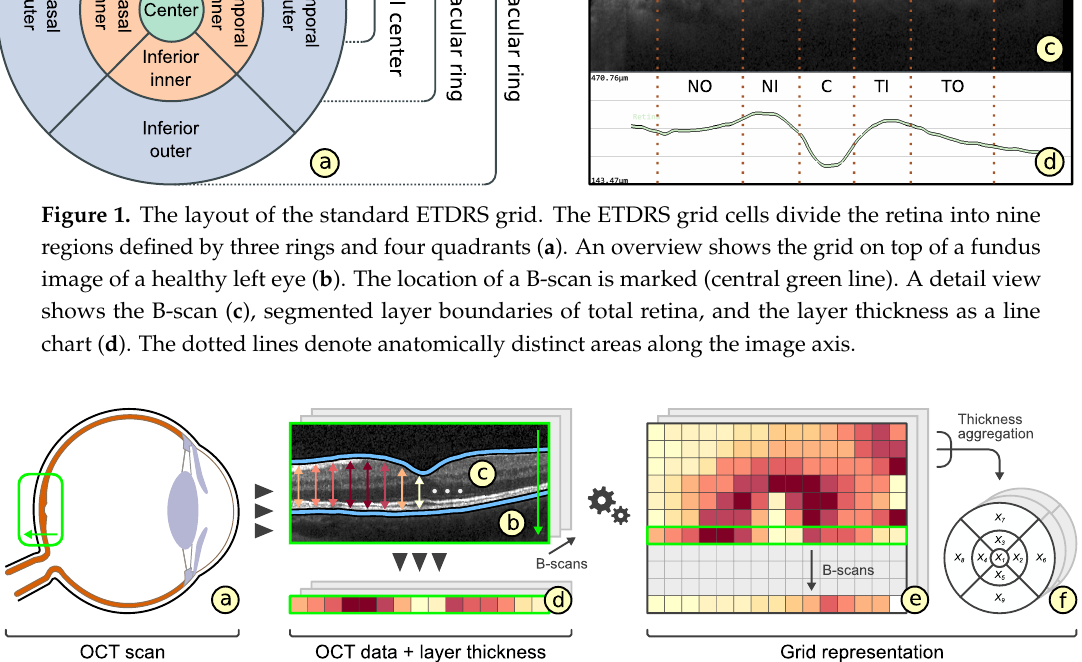
Figure 2. Grid representation of retinal layer thickness. An OCT scan captures the area around the macula and the optic disk ( a ). Multiple B-scans are acquired ( b ). Retinal layers are segmented per B-scan ( c ) and thickness values are computed for every point along the horizontal image axes ( d ). The thickness values are combined per layer ( e ) and aggregated into thickness grids ( f